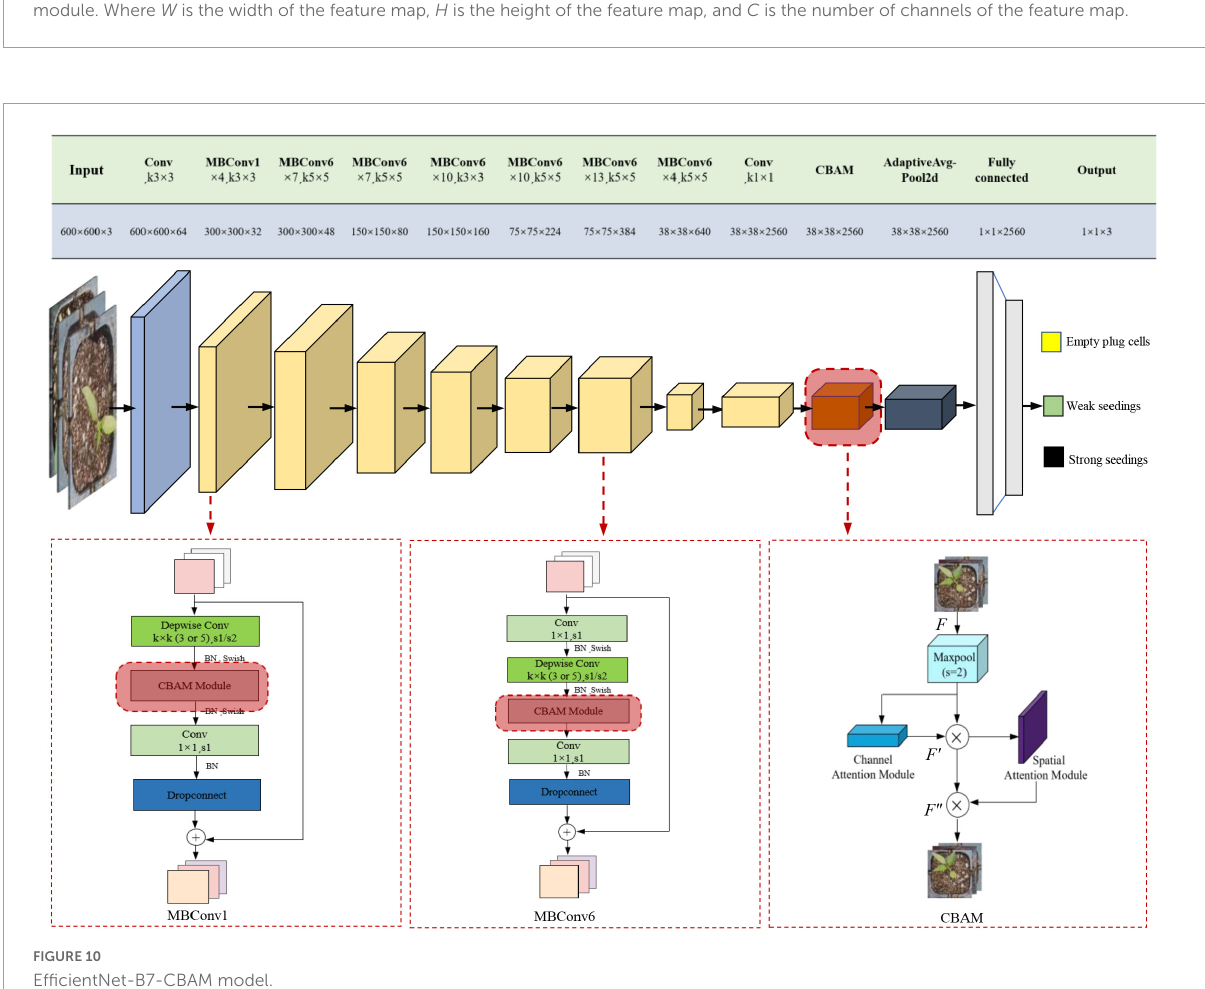
FIGURE10 EfficientNet-B7-CBAM